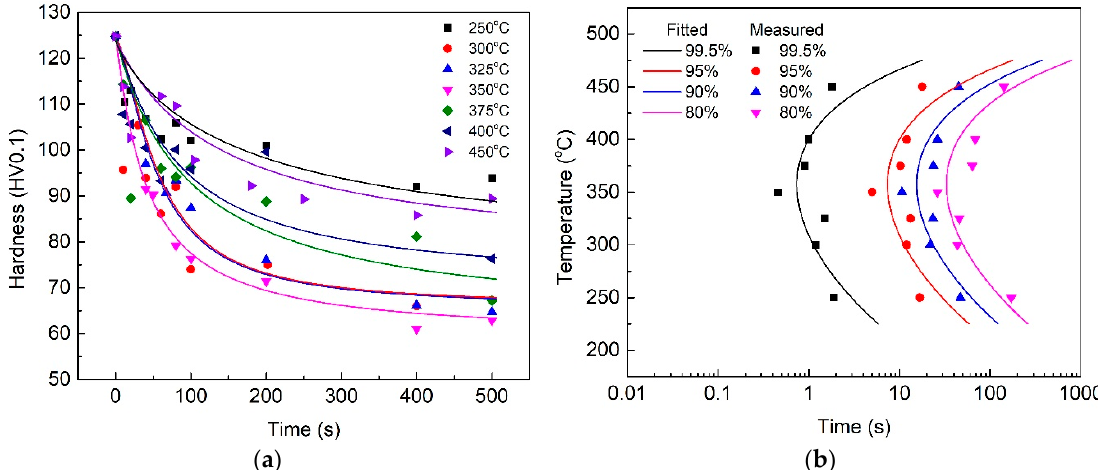
Figure 4. E ff ect of isothermal treatment on the microhardness of quenched PM casting samples ( a ); respective TTP diagram ( b